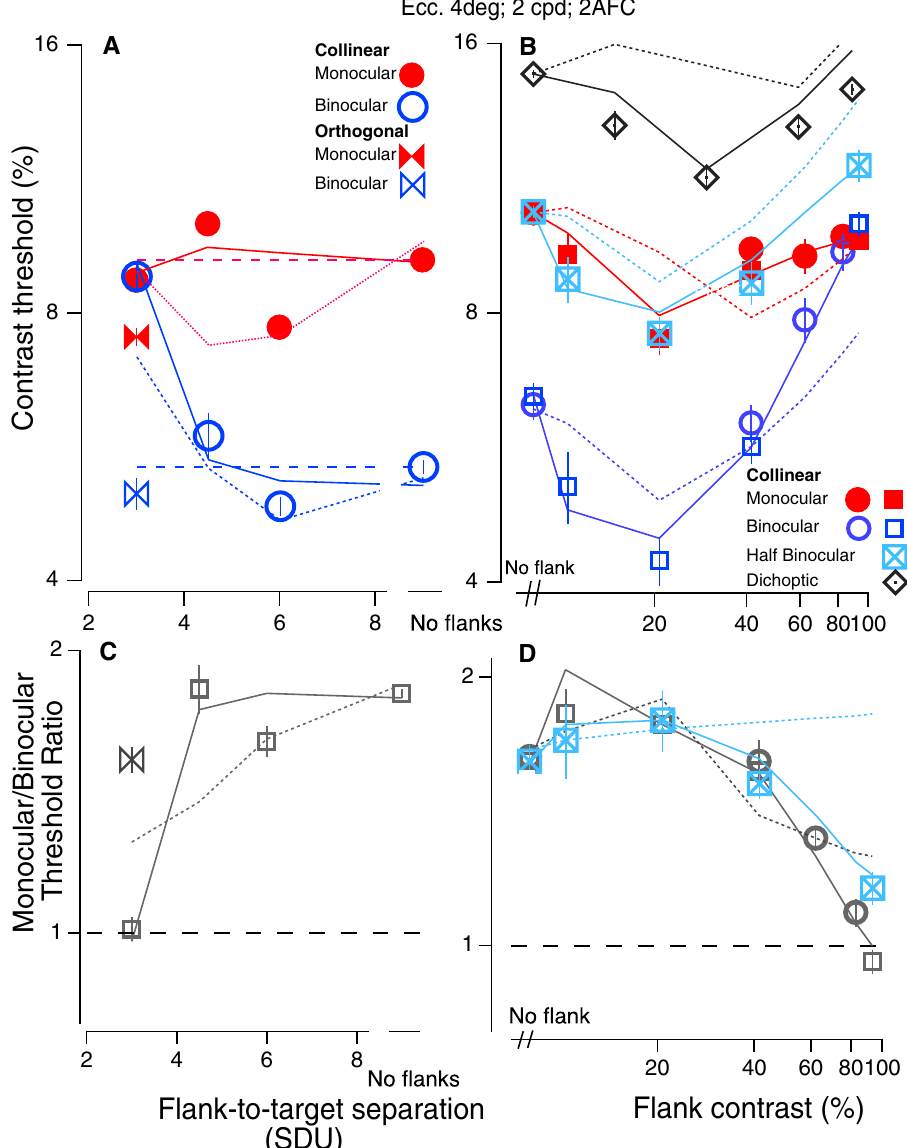
Figure 1. Contrast detection. Contrast detection for binocular (blue) and monocular (red) viewing as a function of flank distance ( A ), with flank contrast = 9.5 × threshold (left; symbols show the mean ± 1se of 6 observers), or as a function of flank contrast. Dashed lines show the unflanked thresholds. ( B ) With abutting flanks (flank-to-target separation = 3SDU; symbols show the mean ± 1se of 5 different observers). Also shown in ( B ) are data under half binocular condition for 3 observers and data under dichoptic conditions for one observer. The solid lines are fits of the GUMI Model, and the dotted lines are fits of the aGUM model (see “Model” for details). ( C , D ) Binocular summation factor (monocular/binocular threshold ratio) from ( A ) and ( B ) respectively. Note that the abscissas in ( B ) and ( D ) are plotted on a logarithmic